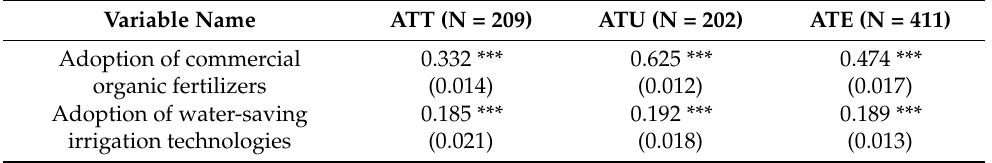
Table 5. Estimated treatment effects of farmers’ cooperative participation on their adoption of commercial organic fertilizers and water-saving irrigation technologies (ESP estimation